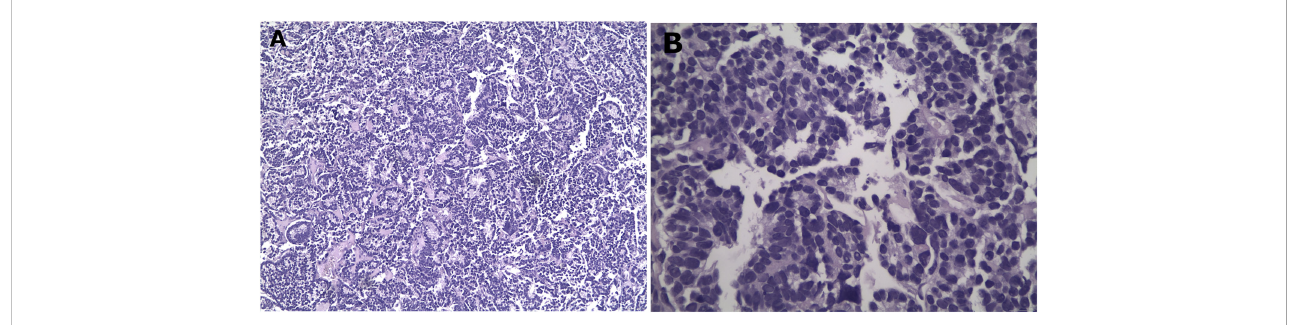
FIGURE 2 Representative histological images from the biopsy specimen. Low (40x) (A) and high (400x) (B) power views showing solid and acinar growth pattern, poor differentiation, eosin – hematoxylin stain.